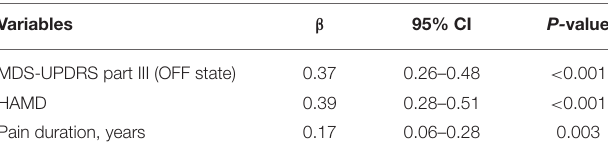
TABLE 2 | Multiple linear regression analysis for variables associated with PDQ-39 scores in PD patients with